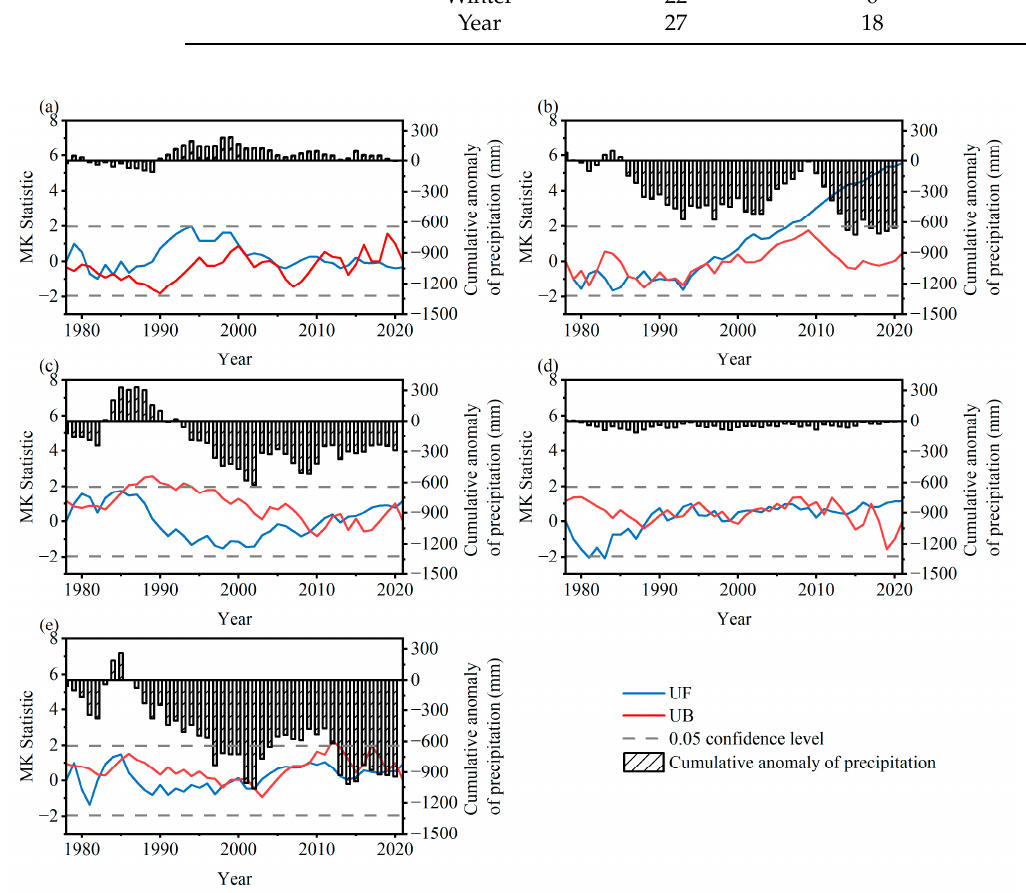
Figure 4. Variation characteristics of precipitation in Henan Province from 1978–2021 under different time scales. ( a – d ) represent the seasonal scale, where ( a ) represents spring, ( b ) represents summer, ( c ) represents autumn, and ( d ) represents winter. ( e ) represents the annual scale.